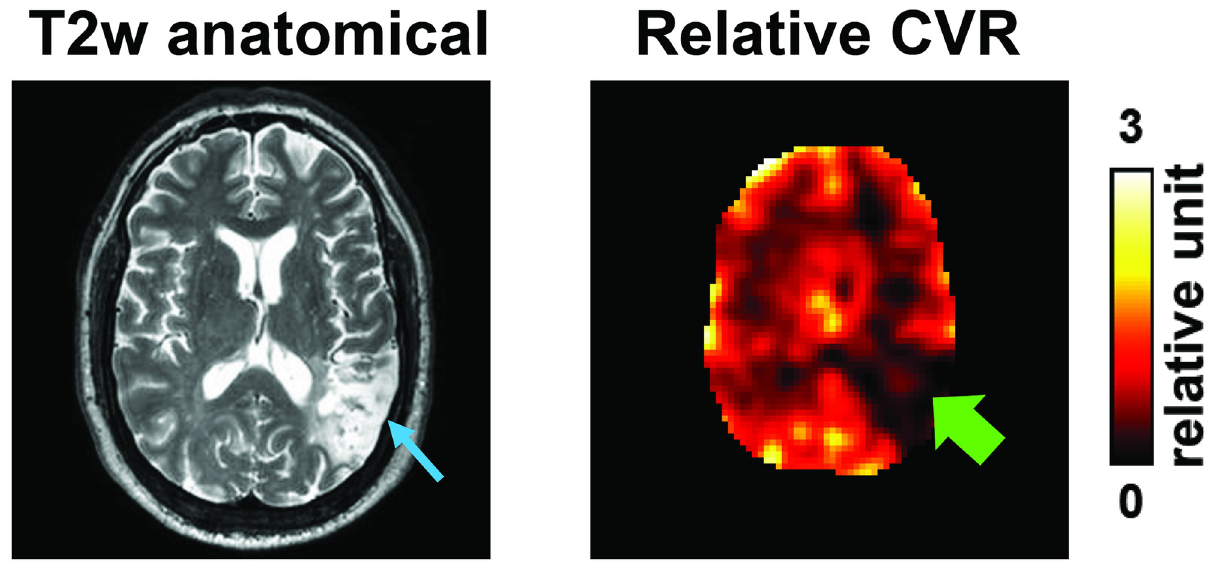
Fig 12. Resting-state CVR map from a patient with stroke (56 year of age, male). The MRI was performed at 24 weeks after stroke onset. Infarcts were identified at temporal lobe, insular region and frontal operculum/inferior lobe. Arrows indicate stroke lesion region in temporal lobe. BOLD imaging parameters were: TR/TE = 2000/30ms, resolution = 3x3x4mm 3 , 210